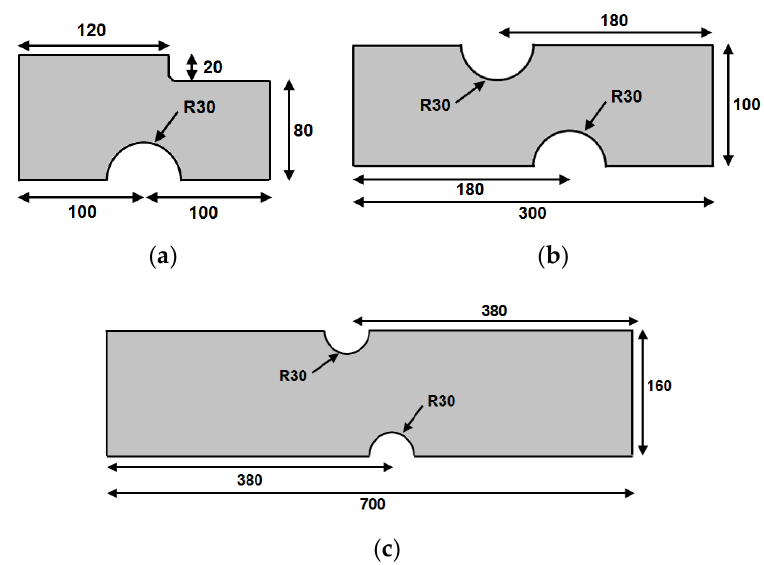
Figure 3. Design of the pieces and strong-backs used in the experiments: ( a ) temporary piece (LA-4); ( b ) strong-back (S-3); and ( c ) strong-back (S-4).